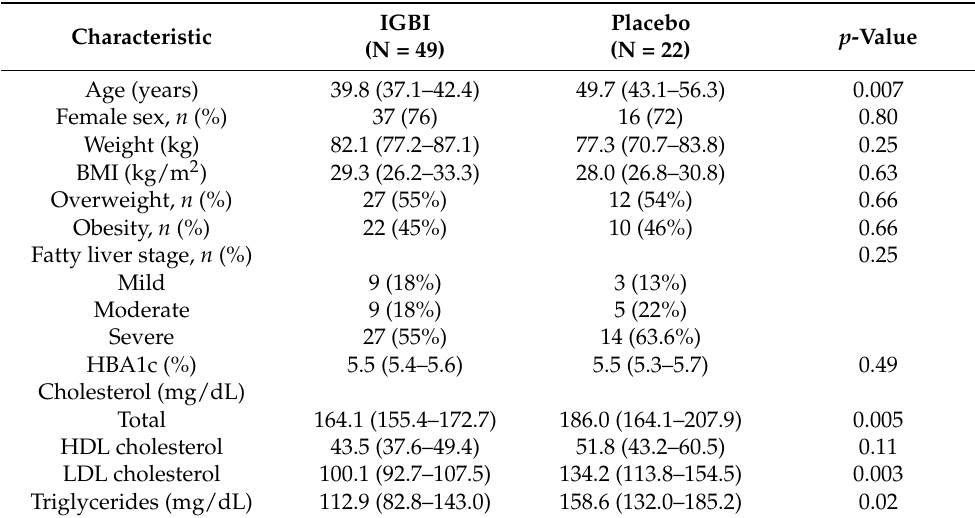
Table 1. Baseline clinical characteristics of the patients.